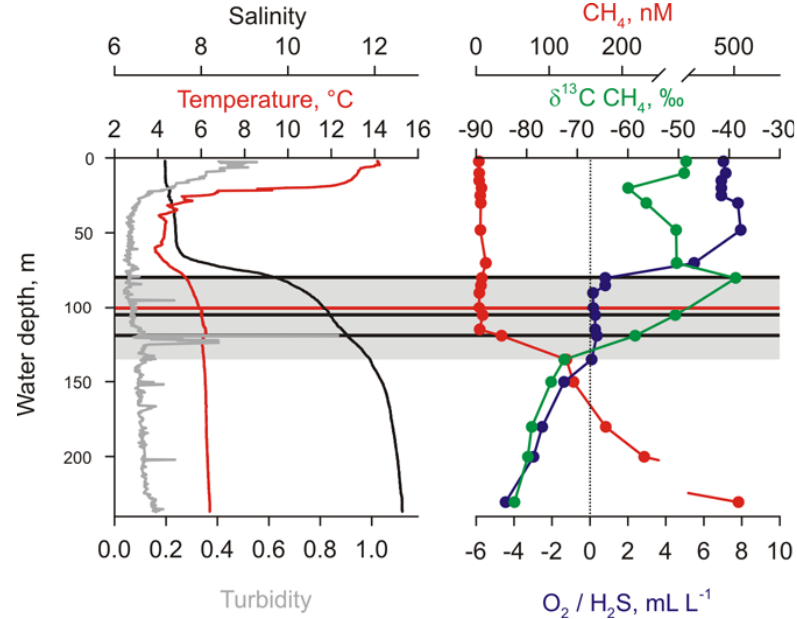
Fig. 2. Left: vertical distribution of salinity (black), temperature (red), and turbidity (grey). Right: vertical distribution of oxygen and hy- drogen sulfide (expressed as negative oxygen equivalents, blue), methane (red), and δ 13 C value of methane (green). The depth interval of the redox-zone is displayed in grey (oxygen concentration 0–0.8mLL − 1 ). The water depths for molecular biological and lipid biomarker studies are indicated with coloured horizontal lines (black = molecular biology, red = molecular biology together with lipid biomarkers).